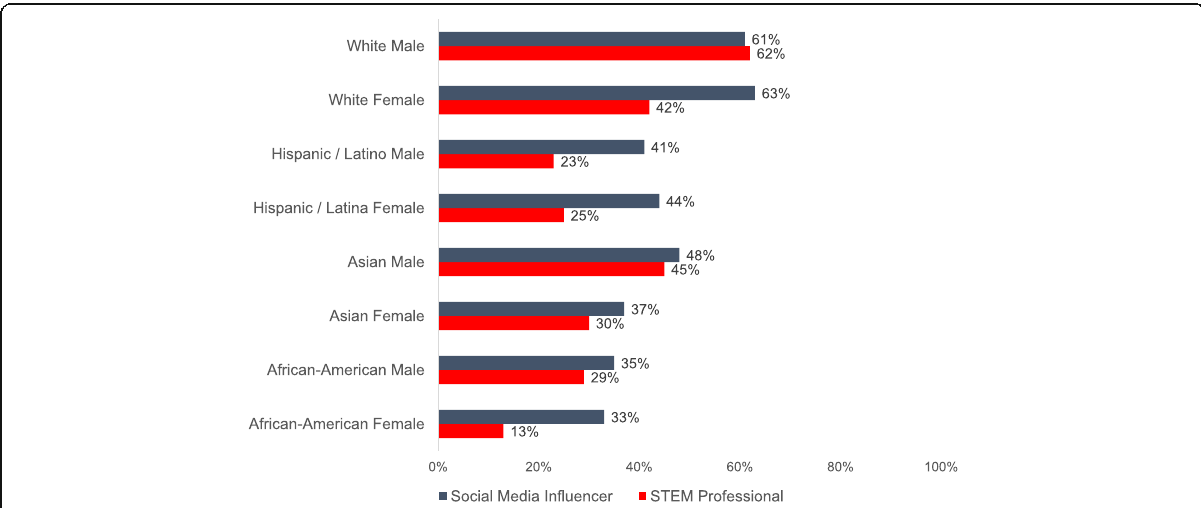
Fig. 3 Familiarity with diverse STEM professionals. Which of the following can you name easily? Respondents were 4 times as likely to be able to